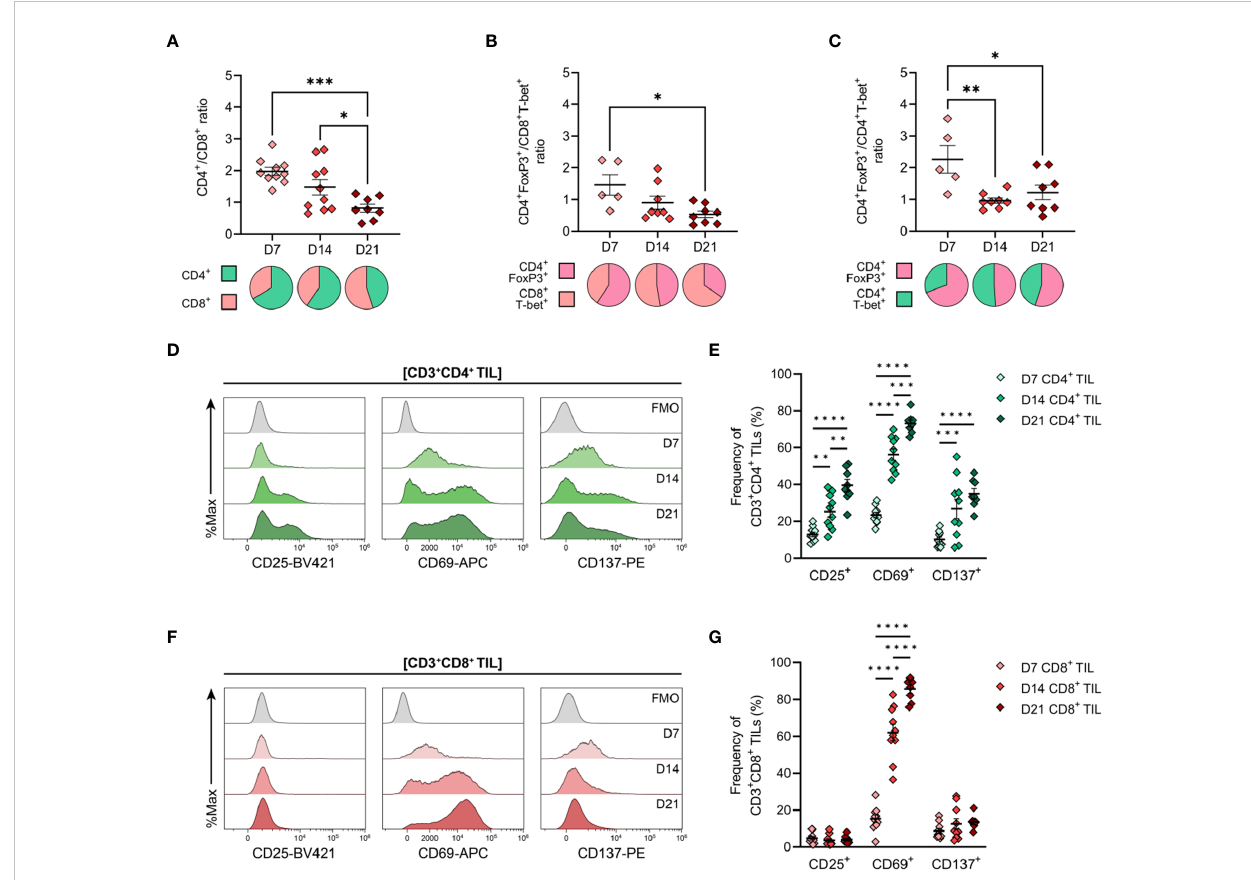
FIGURE 5 General features of T cell in fi ltration in MC38 tumours and expression of activation markers by CD4 + and CD8 + TILs. MC38 tumours were resected 7-, 14- and 21-days post-inoculation (D7, D14 and D21; n = 5-10 biological replicates per timepoint) and mechanically dissociated. Tumour- in fi ltrating lymphocytes (TILs) were then isolated from tumour homogenates and analysed by fl ow cytometry. (A – C) Graphs depict the ratio of CD3 + CD4 + to CD3 + CD8 + TILs (CD4 + /CD8 + ratio, (A) , FoxP3 + CD3 + CD4 + to T-bet + CD3 + CD8 + TILs (CD4 + T REG /CD8 + T EFF ratio, (B) ) and FoxP3 + CD3 + CD4 + to T-bet + CD3 + CD4 + TILs (CD4 + T REG /CD4 + T H 1 ratio, (C) ) during tumour outgrowth (D7, D14 and D21). All ratios were calculated as the quotient of the absolute number of events collected for each of the indicated populations. Pie charts depict relative proportions of indicted populations. (D, F) Representative histogram overlays depicting the expression of activation markers (CD25, CD69 and CD137) by total CD3 + CD4 + ( (D) , green) and CD3 + CD8 + ( (F) , red) tumour-in fi ltrating lymphocytes (TIL) isolated from MC38 tumours 7-, 14- and 21-days post-inoculation (D7, D14 and D21). Corresponding fl uorescence-minus-one controls (FMO, grey) are also shown. (E, G) Frequencies of total CD3 + CD4 + ( (E) , green) and CD3 + CD8 + ( (G) , red) TIL expressing indicated activation markers during MC38 tumour outgrowth (D7, D14 and D21). All data are representative of 5-10 biological replicates per timepoint. Graphs represent the mean and standard error of the mean (SEM, error bars). Statistical analyses were performed using one-way (A – C) or two-way (E, G) ANOVA with post-hoc Tukey test to correct for multiple comparisons. *p ≤ 0.05; **p ≤ 0.01; ***p ≤ 0.001; ****p ≤